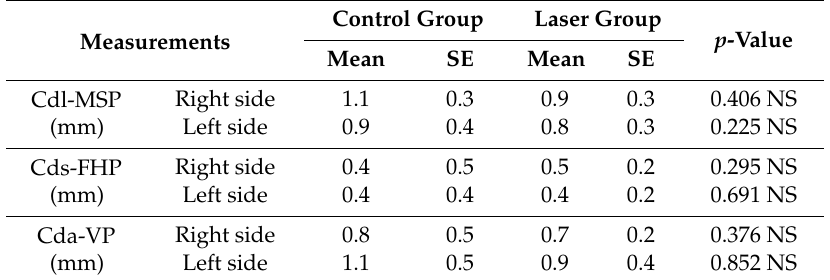
Table 6. Comparison of changes (T1-T2) in CBCT measurements (mm) of condylar position between laser and control groups using independent sample t